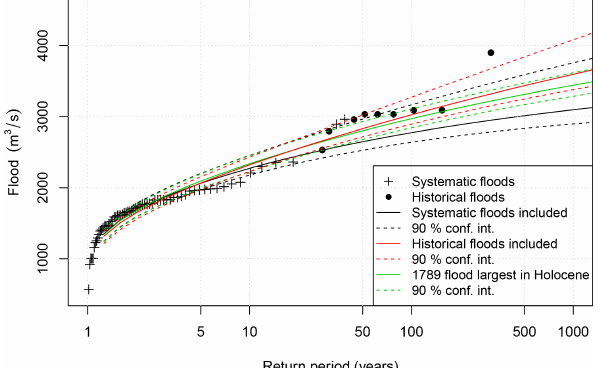
Figure 14. The sensitivity of flood frequency analysis to three dif- ferent combinations of systematic and historical flood data. Annual maximum floods for the period 1872–1836 were used as systematic flood data. Nine historical floods exceeding 2533m 3 s − 1 and repre- senting the period 1653–1871 were used as historical floods. Based on the paleorecord, the 1789CE flood was reweighted to represent a period of 10000 years. The plotting positions for the systematic and historical floods are based on Hirsch and Stedinger (1987) and explained in Sect.